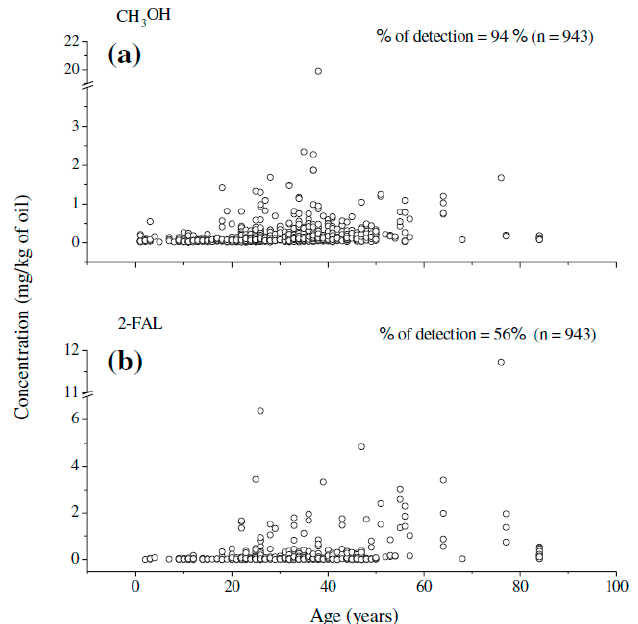
Figure 10. Occurrence of ( a ) methanol and ( b ) 2-furfuraldehyde in oil samples collected from equipment in Hydro-Québec’s transmission network [1].